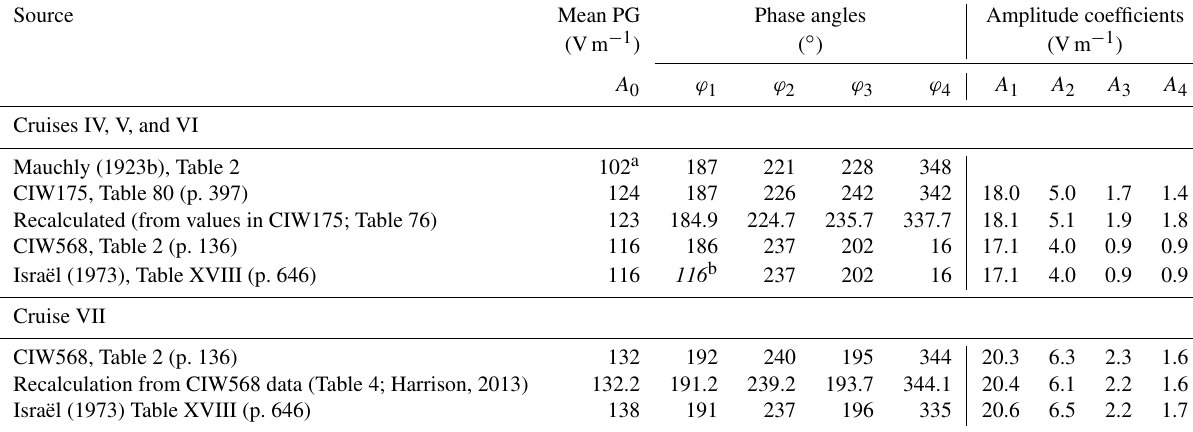
Table 2. Annual harmonic coefficients from Carnegie PG data: absolute variation. Source Mean PG Phase angles Amplitude coefficients